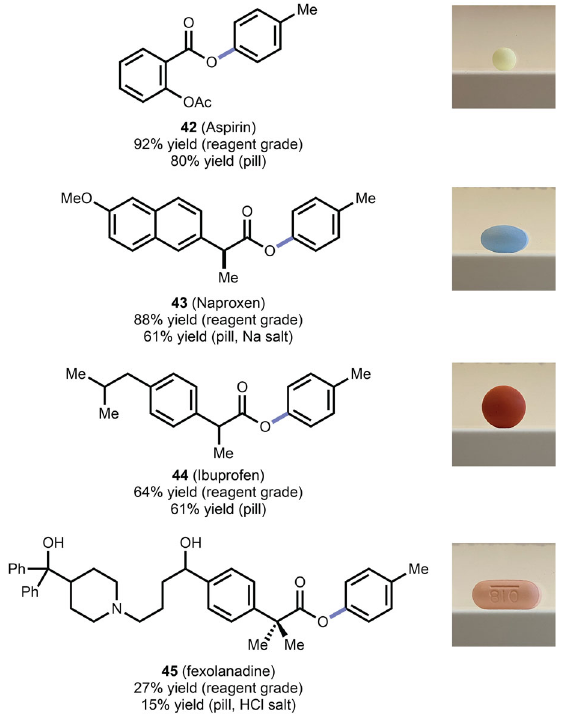
Fig. 5 The amine – acid esteri fi cation applied directly to over-the-counter pills. Ester products 42 – 45 are derived from both reagents and OTC pills (See Supplementary Information for